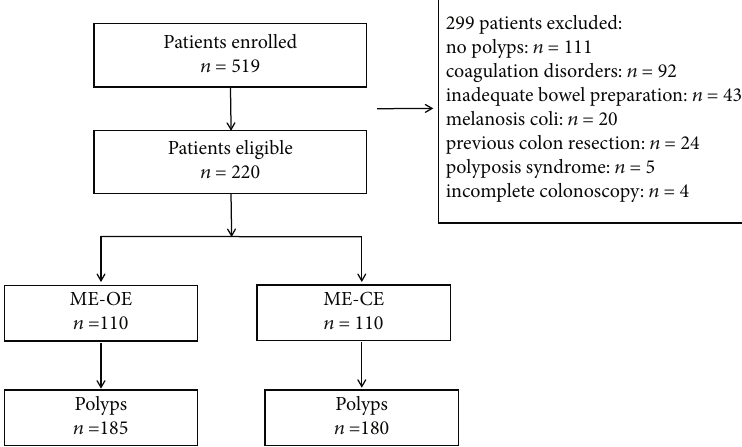
Figure 2: Flow chart of the examinations: 519 patients enrolled, 220 patients eligible (299 patients excluded: no polyps: n = 111 , coagulation disorders: n = 92 , inadequate bowel preparation: n = 43 , melanosis coli: n = 20 , previous colon resection: n = 24 , polyposis syndrome: n = 5 , and incomplete colonoscopy: n = 4